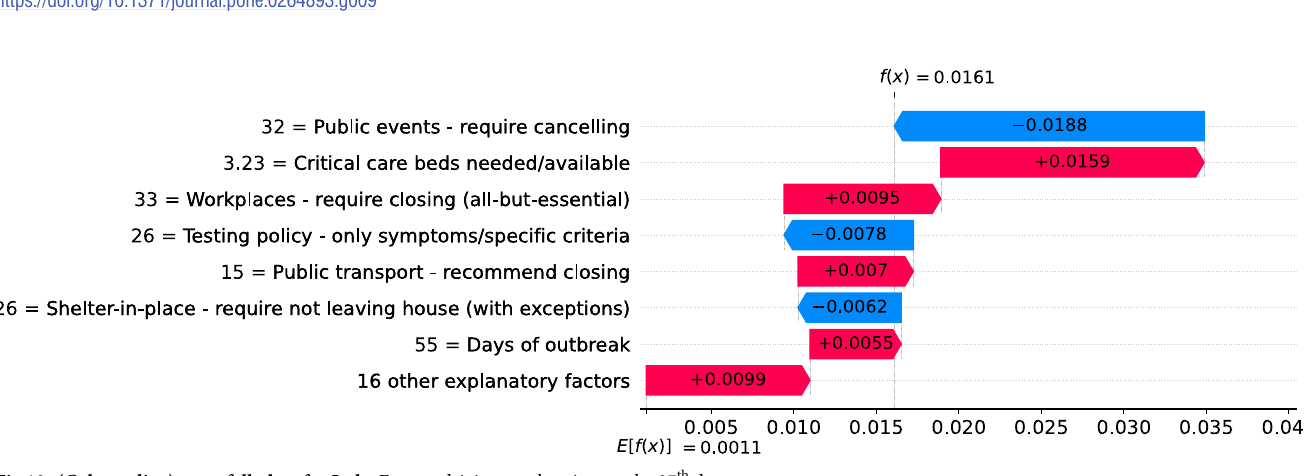
Fig 9. (Color online) waterfall plots for Italy. Factors driving acceleration on the 22 nd day.